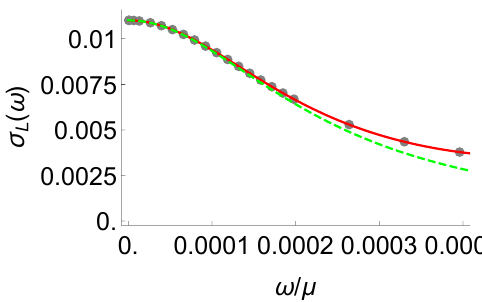
Figure 5. The longitudinal electric charge conductivity against frequency at small frequencies in the Drude-like regime with λ/µ = − 10 − 5 , k/µ = 10 − 1 , T/µ = 0 . 3 and B/µ 2 ≈ 0 . 066 . The solid red line corresponds to the hydrodynamic expression, the grey dots are numerical data, and the dashed Green line shows a pure Drude-like approximation ∼ 1 / ( ω − i Γ)